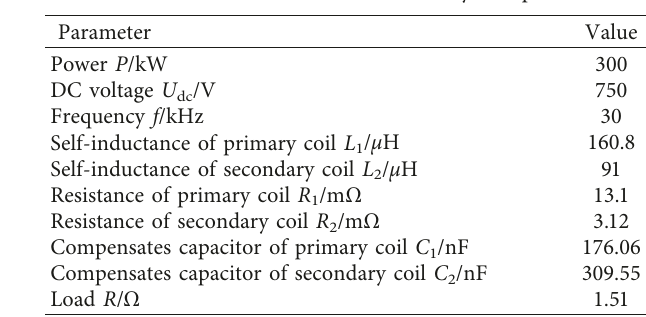
Table 2: Theoretical calculation values of system